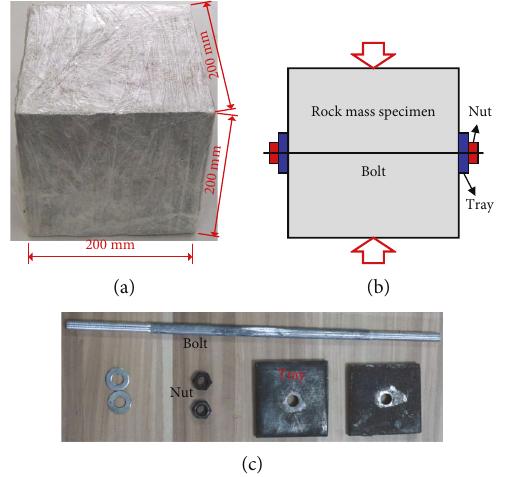
Figure 2: (a) Rock mass specimen, (b) schematic diagram of anchorage method, and (c) bolt and auxiliary appliances.